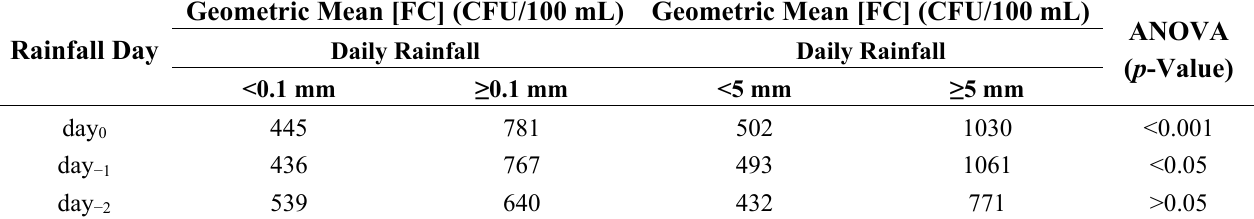
Table 7. Geometric mean of FC concentrations as of function of rainfall height for day 0 , day − 1 and day − 2 and results of the ANOVA test (the given p -values are valid for both thresholds, i.e ., > 0.1 and > 5